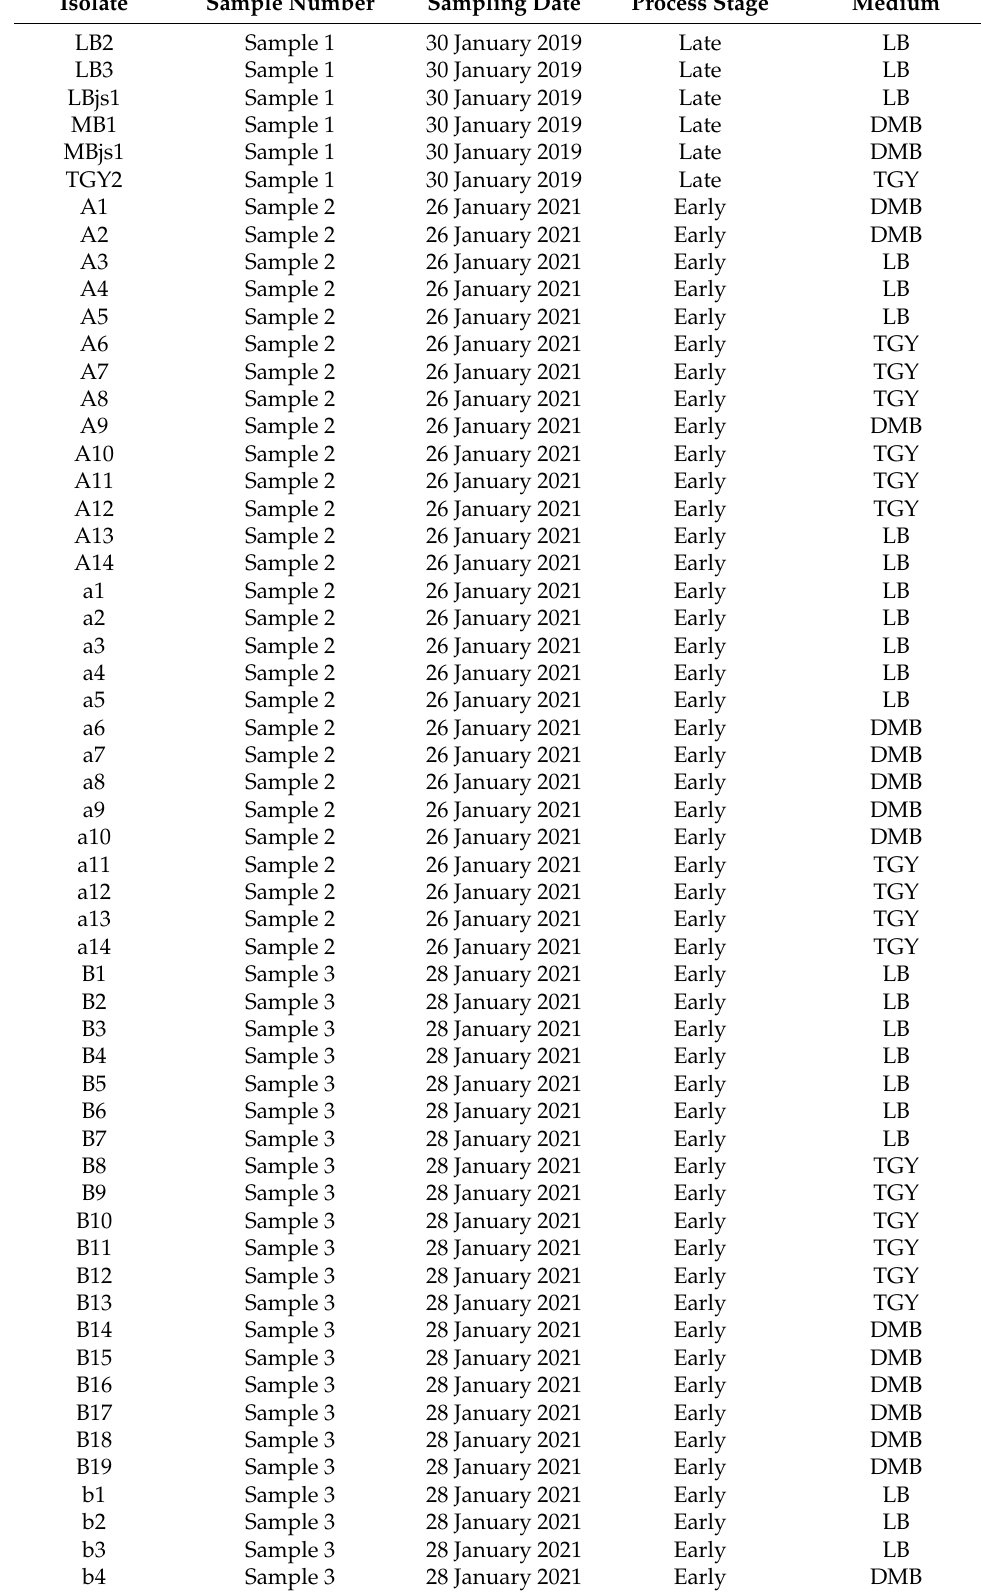
Table 1. Bacillus isolates from the sake brewing process in Shiraki Tsunesuke Sake Brewery.